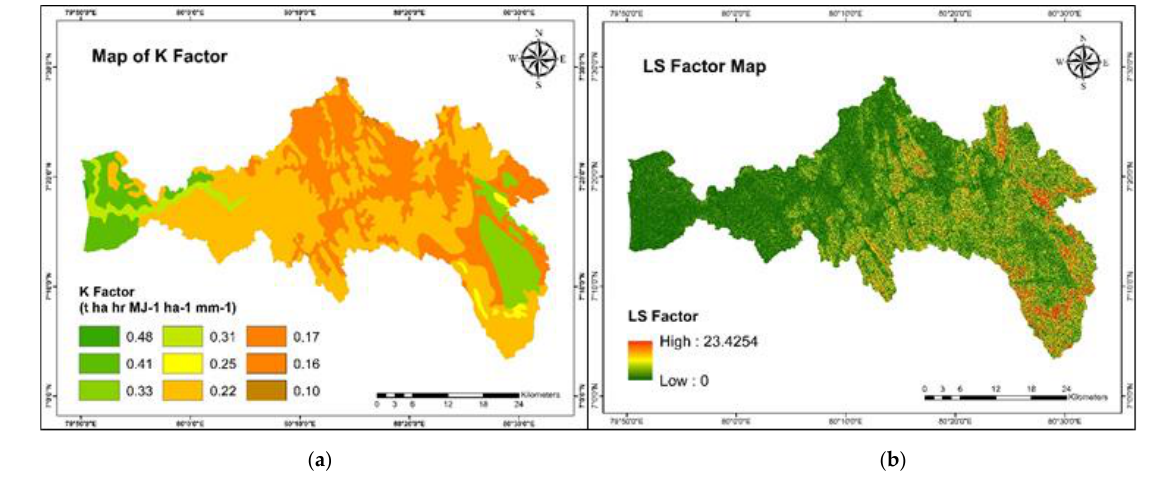
Figure 9. ( a ) Soil erodibility (K) factor map and ( b ) Slope length and steepness (LS) factor map.